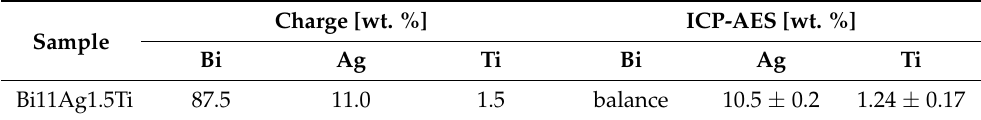
Table 1. Composition of Bi-Ag-Ti alloy and the results of chemical analysis by ICP-AES method [wt. %].